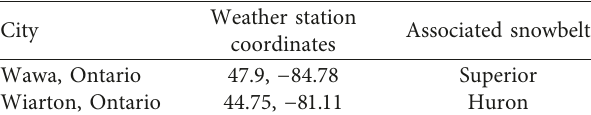
Table 2: Cities analysed in this study with corresponding geo- graphic coordinates and Ontario